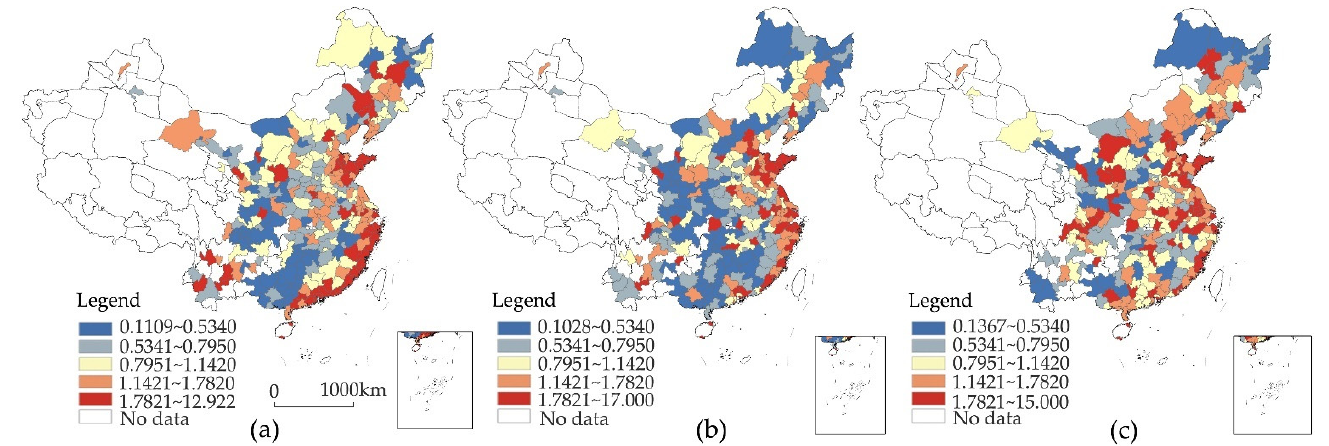
Figure 2. The spatial distribution and evolution of ER intensity. ( a ) The intensity of environmental regulation in 2003; ( b ) the intensity of environmental regulation in 2008; ( c ) the intensity of environmental regulation in 2013. Table 2. Univariate and bivariate global Moran’s I statistics for ER and LP.